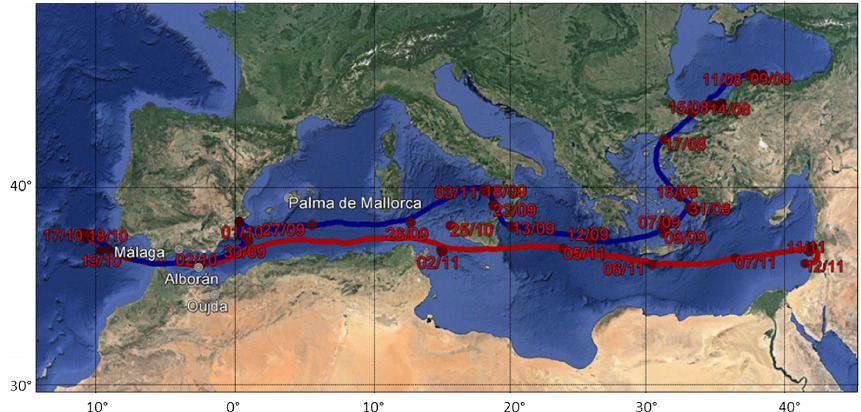
Figure 1. Map of Mediterranean basin showing the location of Alborán Island, Málaga, Oujda and Palma de Mallorca and a MAN cruise track over the Mediterranean Sea, Black Sea and Atlantic Ocean during 26 July–13 November 2011.